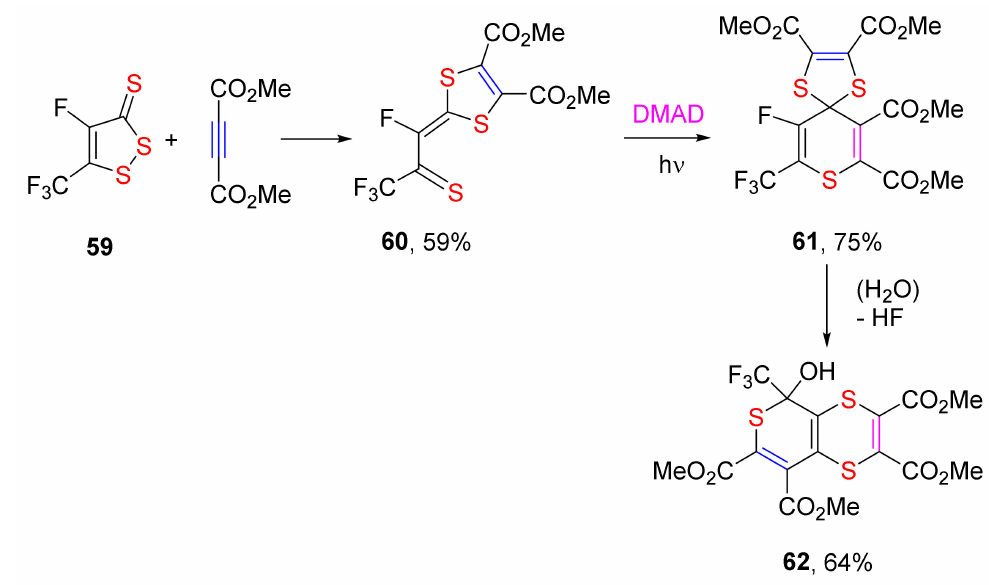
Scheme 41. Reaction of 4-fluoro-5-trifluoromethyl-1,2-dithiole-3-thione with